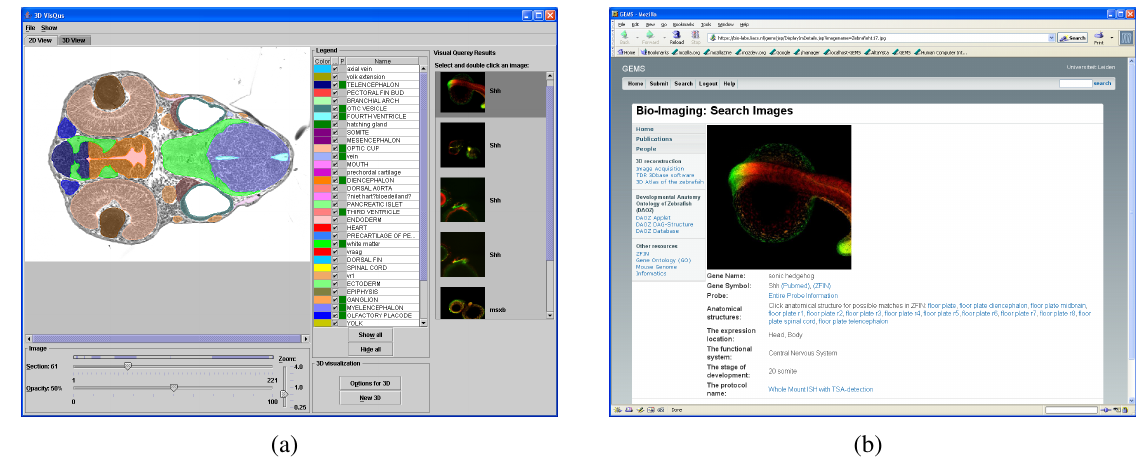
Figure 5: This figure shows the mapping between the 3D atlas and the GEMS. (a) A 2D section from a 3D model; it serves as a query interface. Users choose and click on an anatomical structure. This action is translated into a query (e.g. what patterns are expressed in spatial location X at time Y?). This query is executed against the GEMS database and a list of patterns of gene expression is listed. Each pattern is linked to GEMS database. (b) From the patterns list, a detailed view of a pattern could be